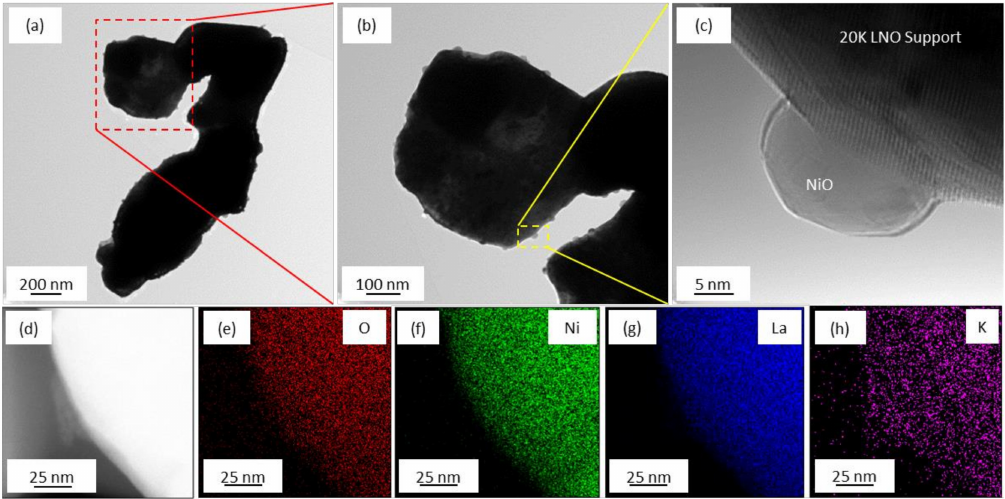
Figure 3. ( a – c ) TEM images of the fresh 20K LNO catalyst and ( d – h ) EDS mapping of O, Ni, La, and K on the surface of the